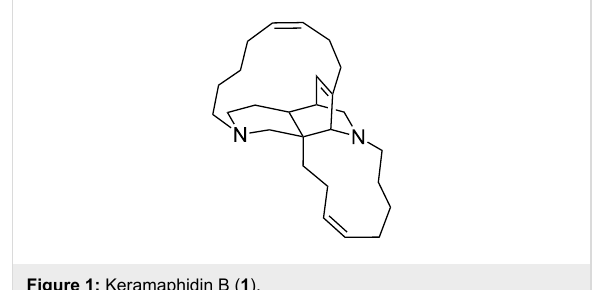
Figure 1: Keramaphidin B ( 1